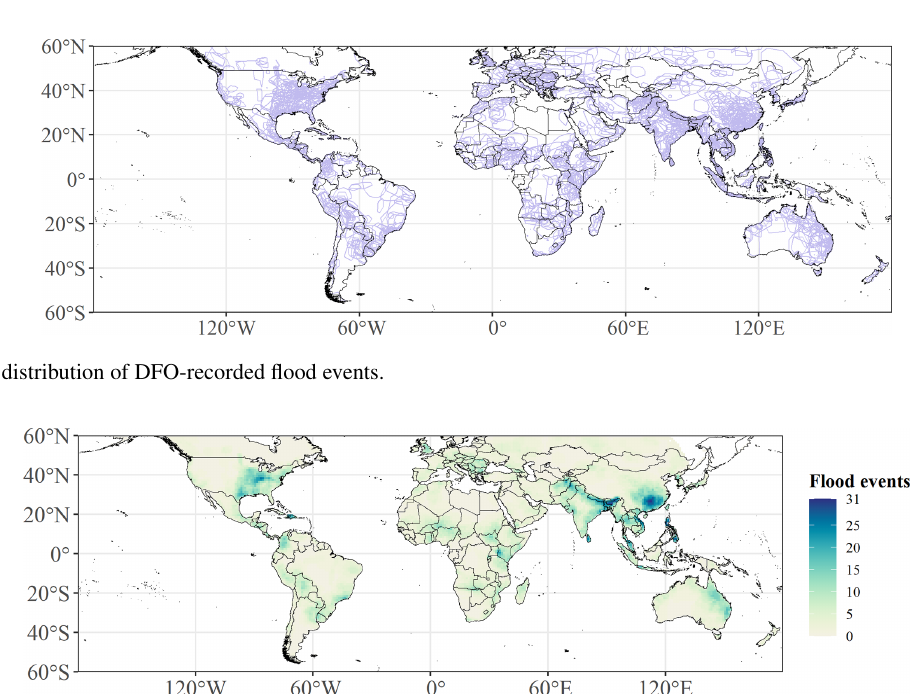
Figure 9. The frequency of flood events recorded by DFO distributed on 1 ◦